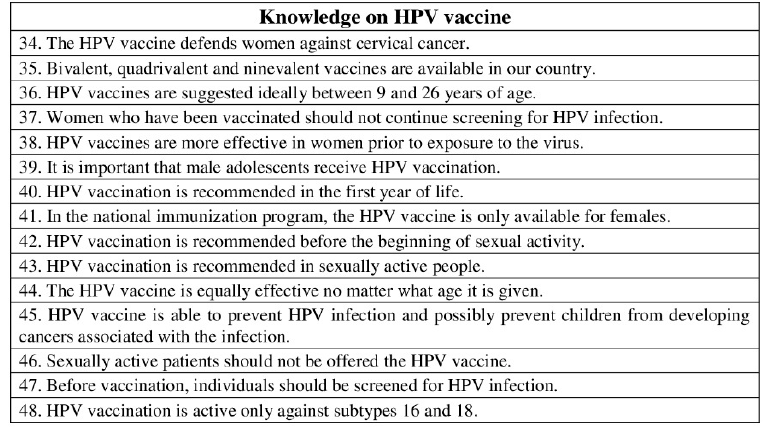
Figure 3. Questionnaire assessing pediatric dentists’ knowledge on HPV vaccine. Statements used